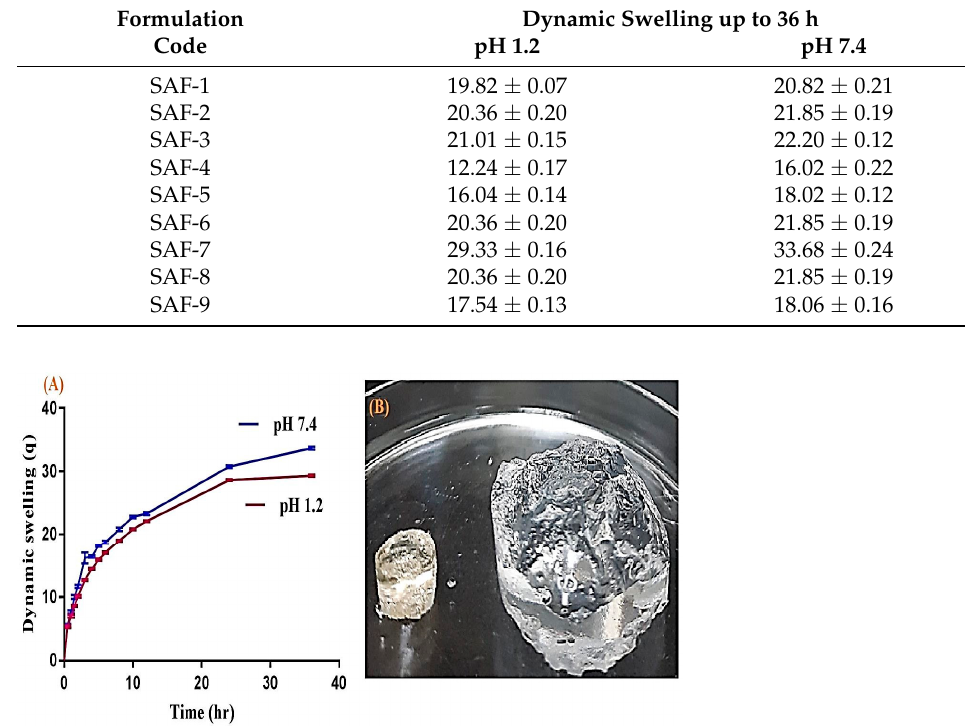
Figure 7. ( A ) Dynamic swelling of SA-co-poly(AMPS) hydrogels at pH 1.2 and pH 7.4, ( B ) dried and Figure 7. (A) Dynamic swelling of SA ‐ co ‐ poly(AMPS) hydrogels at pH 1.2 and pH 7.4, (B) dried and swelled form of SA ‐ co ‐ poly(AMPS) hydrogels . swelled form of SA-co-poly(AMPS)